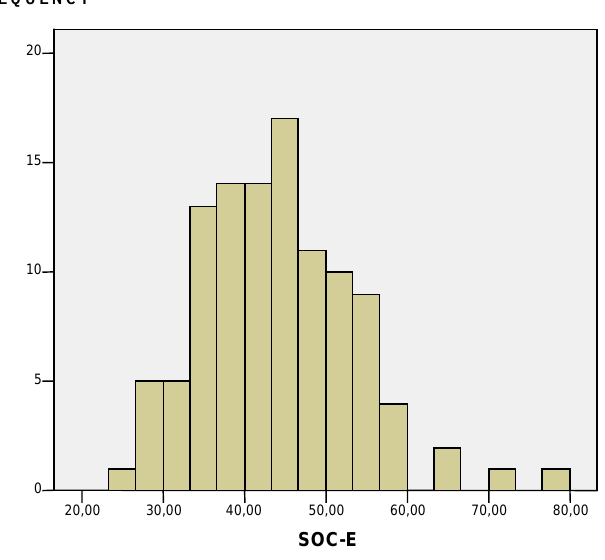
FIGURE 1. The distribution of respondents according to